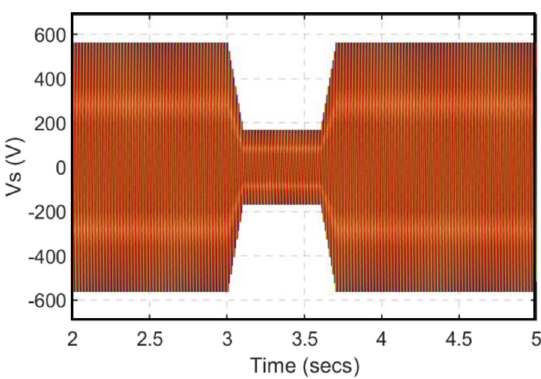
Fig. 8 Voltage dip at the stator windings terminals